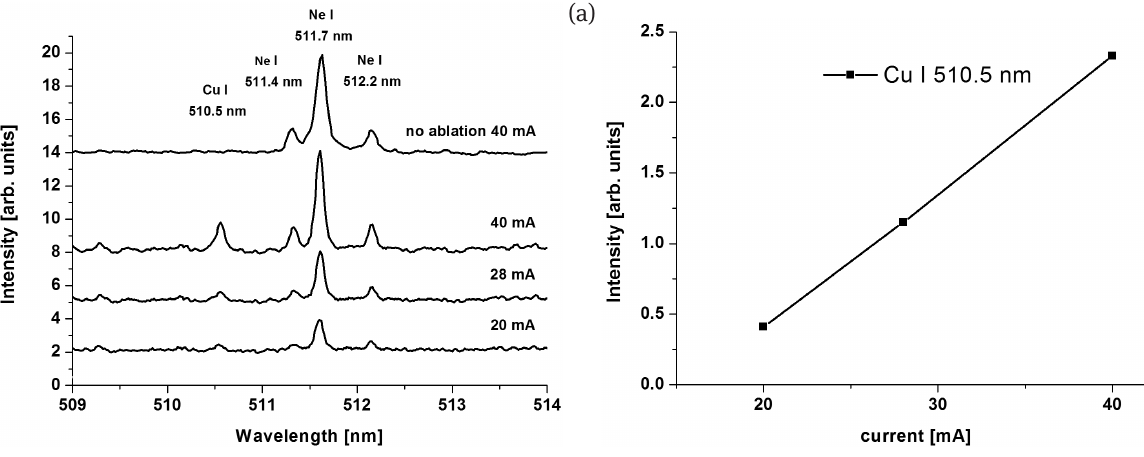
Figure 5 : Intensity of Cu I 510.5 nm spectral line from LIP-HCD as a function of discharge current at 7 Torr discharge